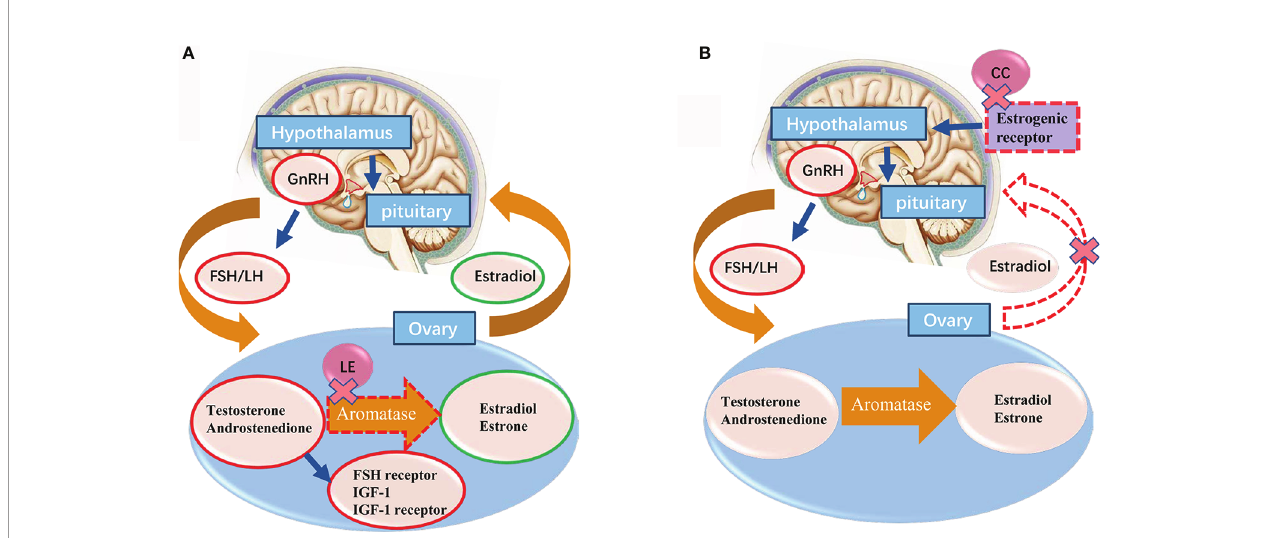
FIGURE 1 | (A) The proposed mechanisms of letrozole for ovarian induction are centrally effect on releasing the pituitary-hypothalamic axis from estrogen negative feedback and locally effect on blocking the conversion of testosterone to estradiol and androstenedione to estrone in ovary. With the concomitant accumulation of androgens inside the ovary, promoting the follicular FSH receptor, IGF-1 and IGF-1 receptor expression, which in turn stimulates follicular growth. Normal central feedback mechanisms remain intact in letrozole ovarian induction protocol. (B) Clomiphene citrate administration induces gonadotropin release by binding to the estrogen receptors (ERs) in the hypothalamus, thereby blocking the negative feedback effect of estradiol. Red circle means increase, green circle means decrease. GnRH, gonadotrophin-releasing hormone; FSH, follicle-stimulating hormone; LH, lutenizing hormone; IGF, insulin-like growth factor; LE,